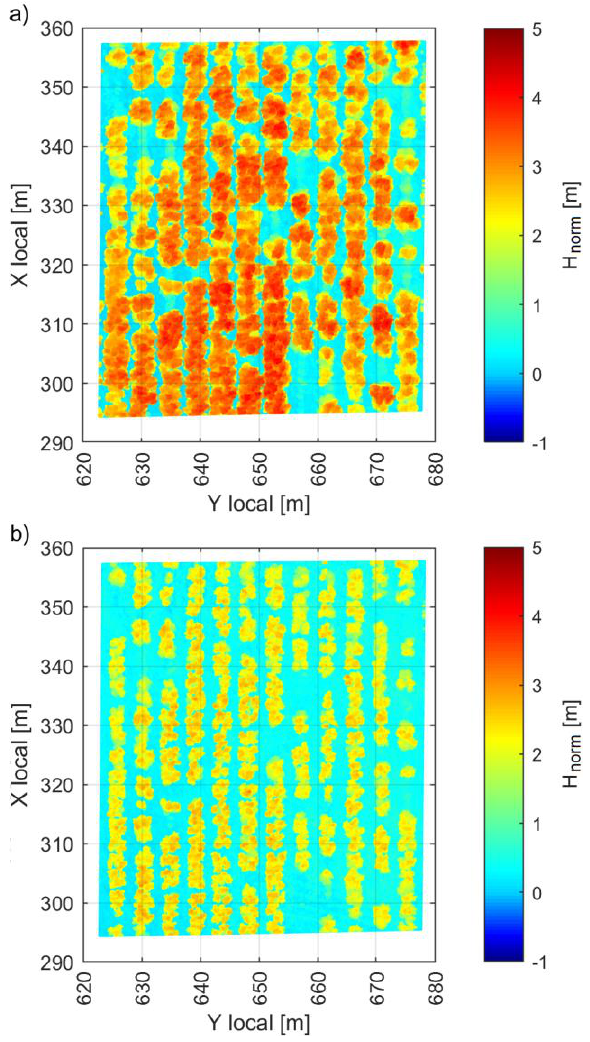
Figure 2. Normalized point cloud of the test area for the a) leafy and b) leafless period; color-coded using height